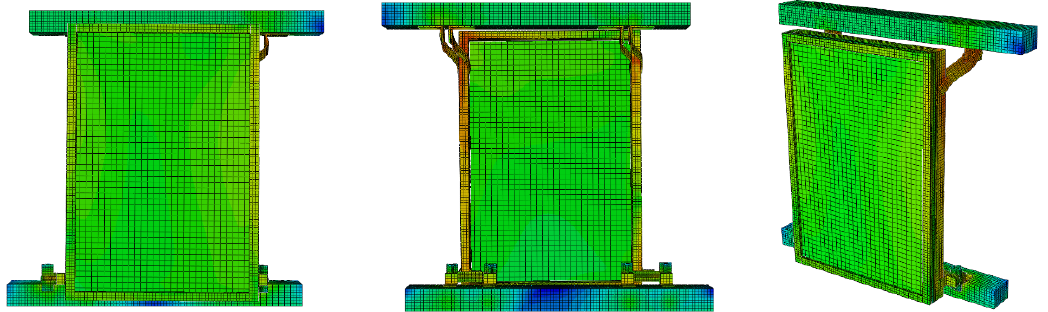
Figure 33. Seismic curtain wall deformation: linear guide length 50 mm.